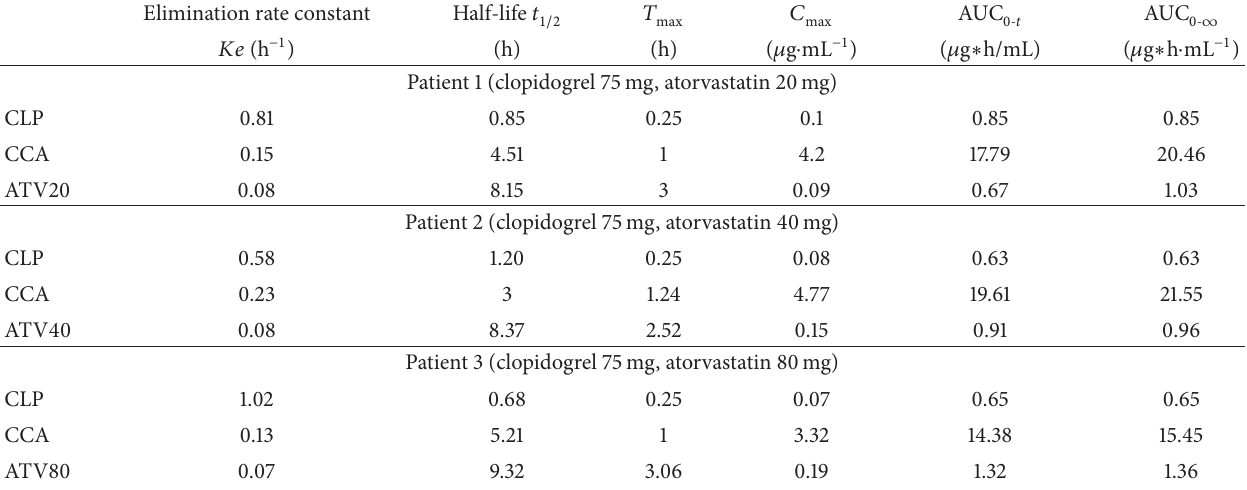
Figure 5: Chromatograms of acid (a), basic (b), and oxidative (c) stress degradation samples of atorvastatin calcium (1,2-degradation products). Table 7: Pharmacokinetic parameters for clopidogrel bisulfate, its carboxylic acid metabolite, and atorvastatin calcium. Elimination rate